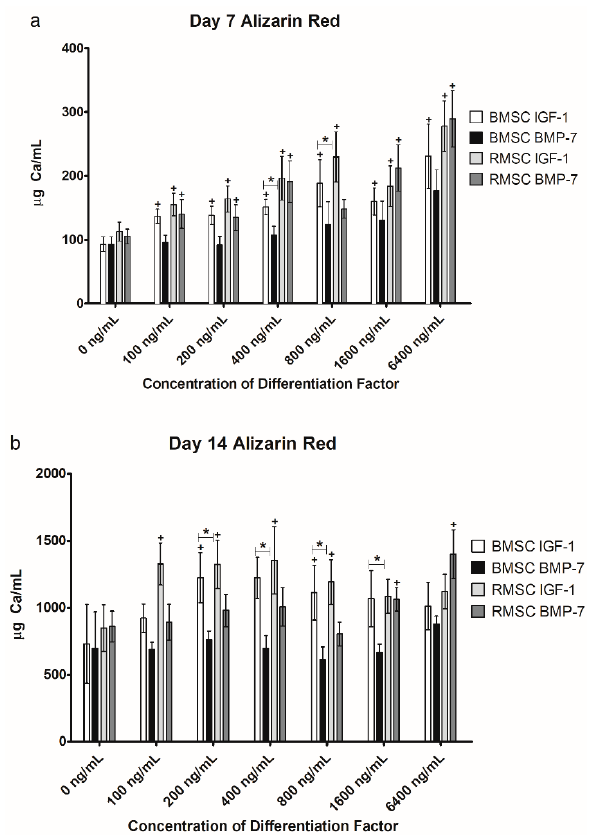
Figure 3. Results of the Alizarin Red staining, showing day 7 ( a ) and 14 ( b ) separately for increased clarity. Results are displayed as bar graphs with the standard error of the mean shown as whiskers above and below each bar. Results for iliac crest bone marrow (BMSC) stimulated with Insulin-like Growth Factor-1 (IGF-1) are always shown in the first bar, followed by BMSC with Bone Morphogenetic Protein-7 (BMP-7), reaming debris (RMSC) with IGF-1, and finally RMSC with BMP-7. * marks significant differences in the two adjacent bars underneath it, + marks significant differences between the bar underneath it and the corresponding unstimulated control group. All measurements were carried out in both biological and technical